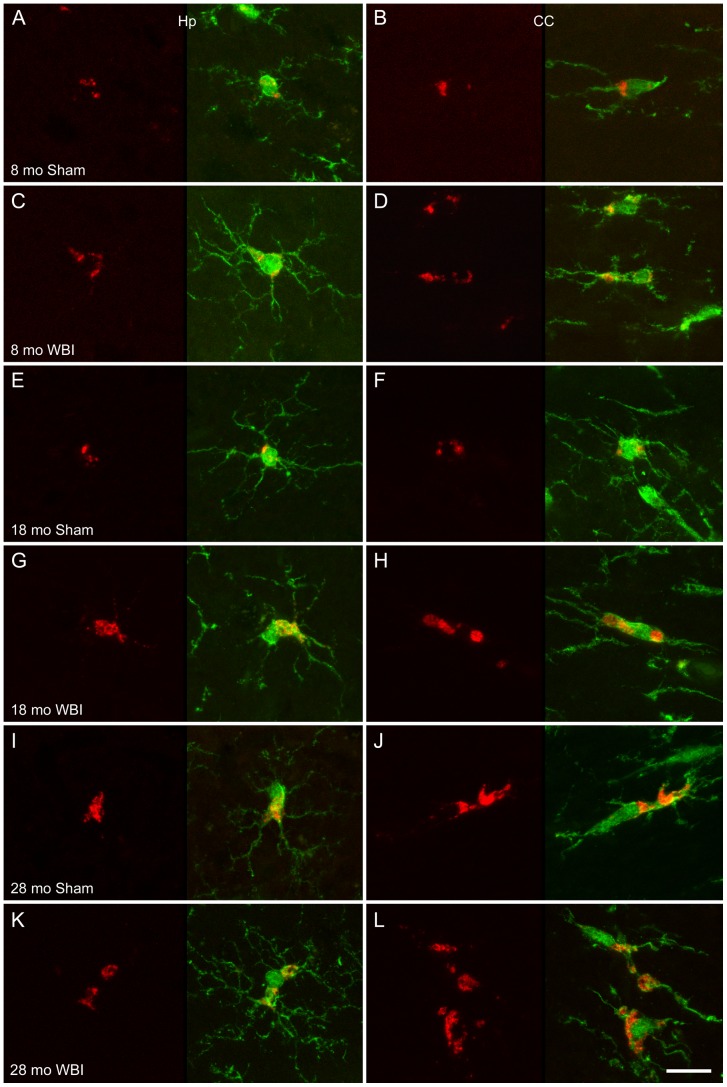
Morphology of ED1+ microglia.Representative examples of double-IF labeling with ED1 (red) and anti-Iba1 (green) are shown from animals of the indicated ages and conditions. For each example an image stack was collected (Z step = 0.5 or 1 µm) and projected to a single image plane (maximum intensity function; left panel ED1 only, right panel merged image). Examples from the hippocampus (Hp, CA1 or CA3) are shown on the left and from the CC on the right. ED1 labeling was most common in the perinuclear region but also appeared in enlarged regions of the cell body (e.g., as in D and G–L) and sometimes within cell processes (e.g., upper cell in L). Intensity levels in some images were adjusted to optimize demonstration of the location of ED1 labeling and the morphology of Iba1+ cells; therefore, differences in brightness do not necessarily reflect differences in labeling intensity. Scale bar = 15 µm.